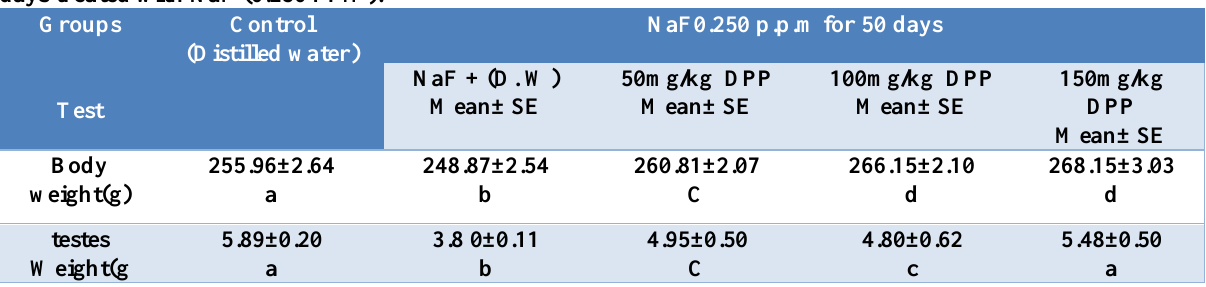
Different letters refer to significant (p<0.05) differences compared between groups. Table, 3: Effect of administration of DPP (50,100,150) mg/kg on Body and testes weight (g) in male rat after 50 days treated with NaF (0.250 PPM).